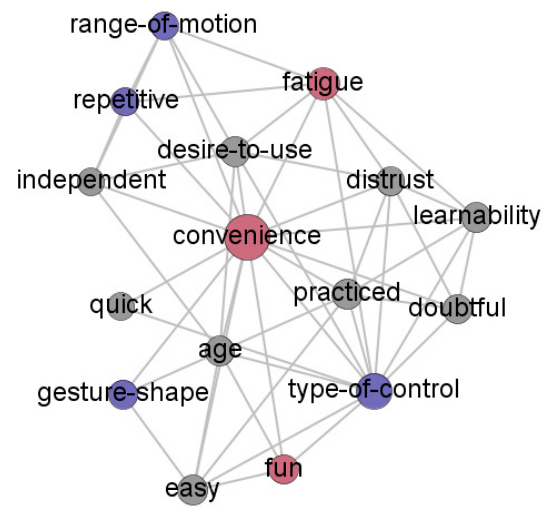
Figure 4. Partial semantic network of convenience (red and blue nodes indicate core values and design variables, respectively).